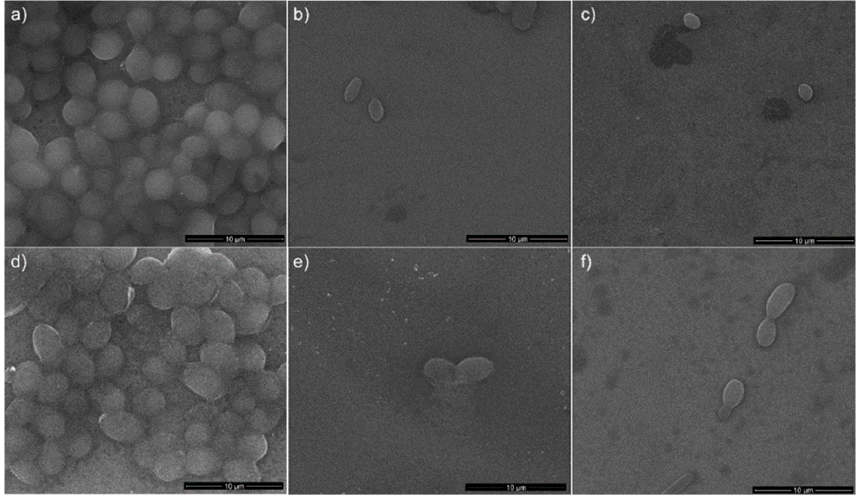
Figure 12. SEM images of Candida albicans ATCC 10231 cell development on Ti discs used as control ( a , d ) and Ag: HAp-S1 and Ag: HAp-S2 composite layers at the two time intervals T0 (Ag:HAp-S1_T0 ( b ) and Ag:HAp-S2_T0 ( c )) and T6 (Ag:HAp-S1_T6 ( e ) and Ag:HAp-S2_T6 ( f )) after 24 h of incubation.